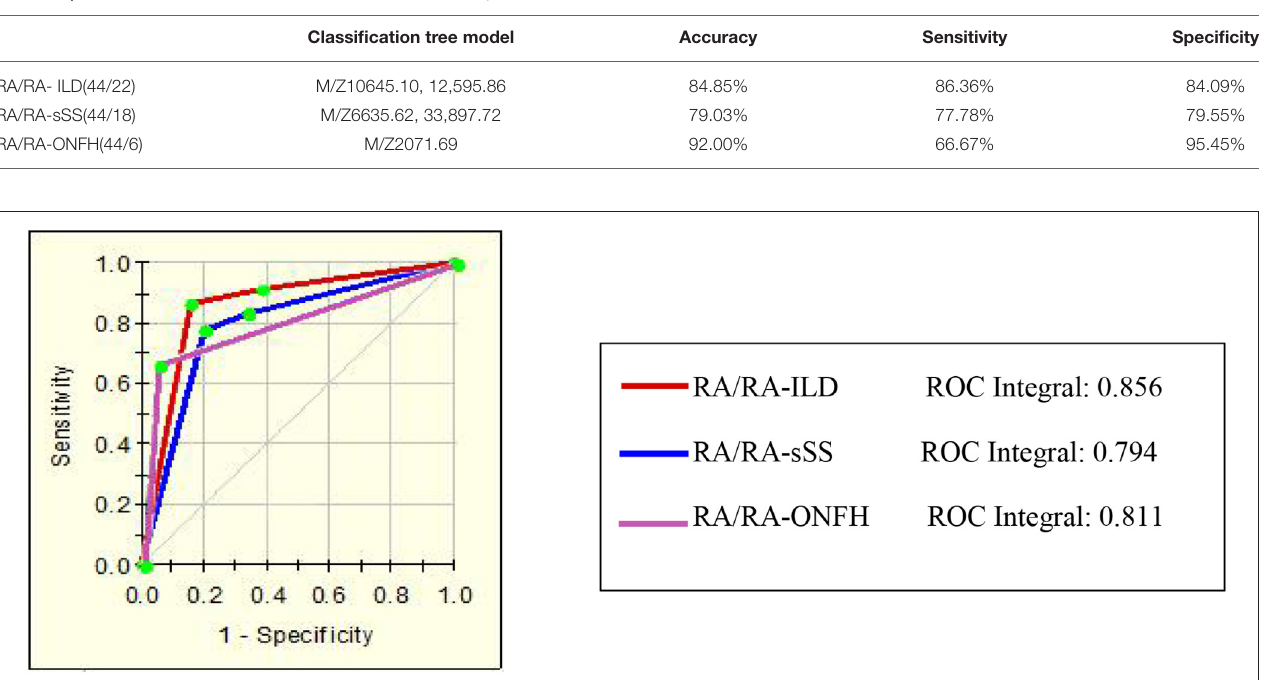
TABLE 7 | The classification tree models for RA and RA with complications.